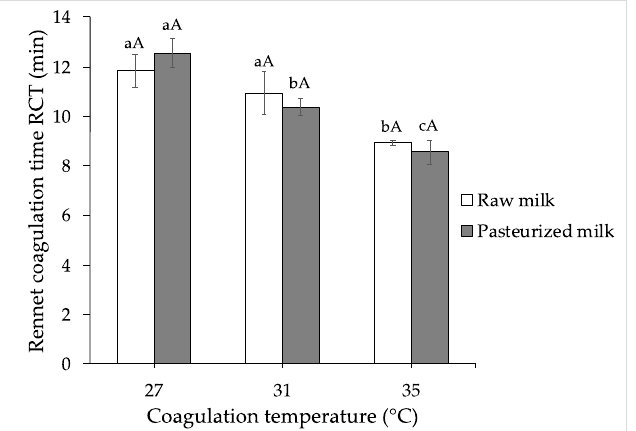
Figure 7. Influence of coagulation temperature and heat treatment of milk on rennet coagulation time RCT (min). Values with different lowercase letters (a, b, c) represent differences between the coagulation temperature levels of the same milk, uppercase letters indicate no differences between milk heat treatments (raw/pasteurized). Comparison of means was performed by Tukey HSD test ( p < 0.05).